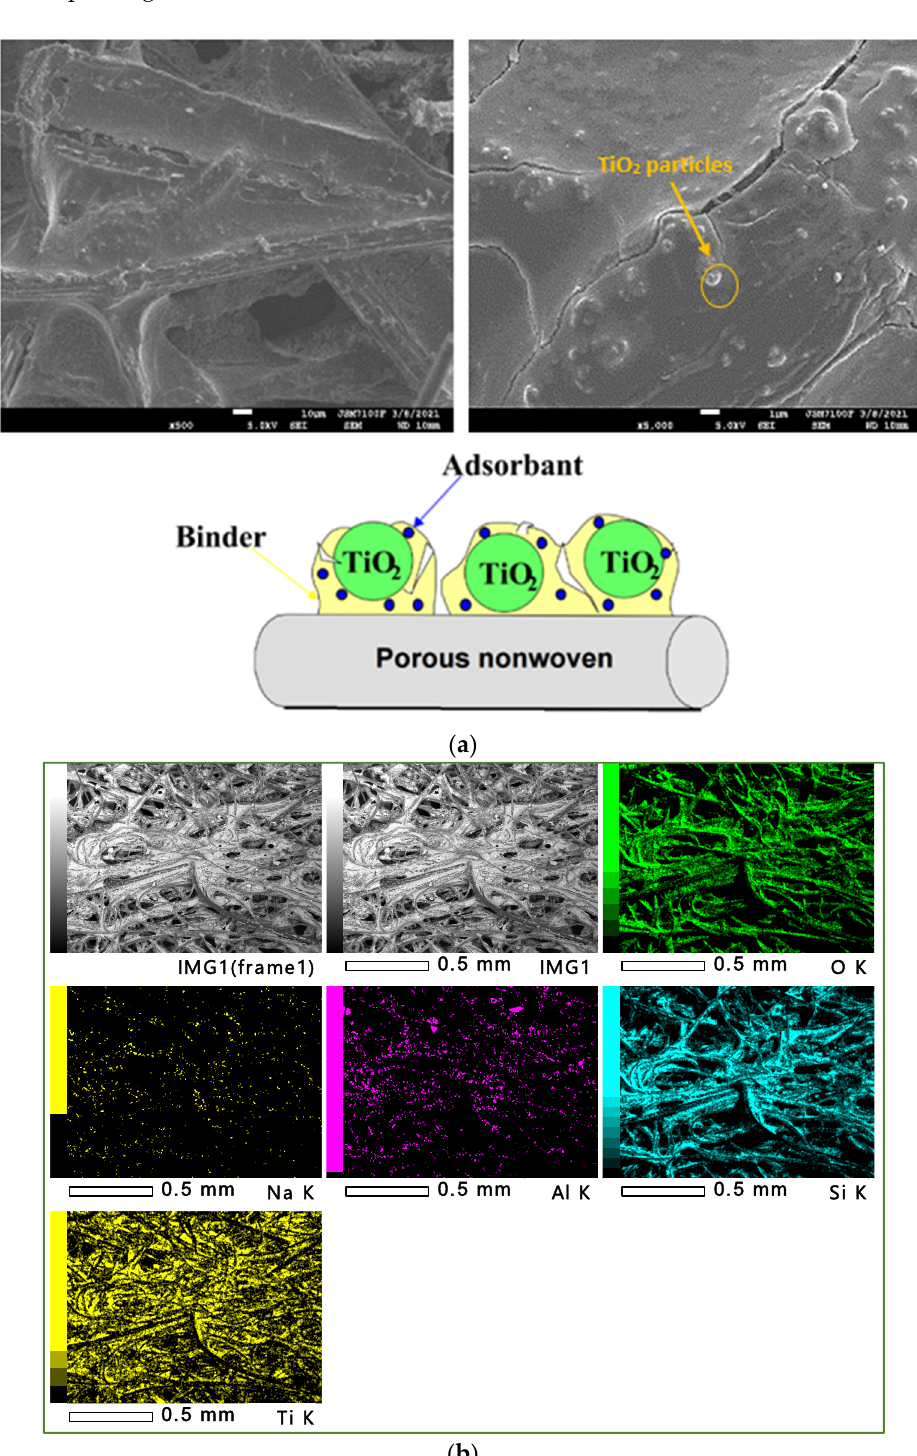
Figure 1. ( a ) Catalyst images under a scanning electron microscope, SEM (×500 and ×5000 as mag- nification ratios), with an illustrative presentation of the suspended TiO 2 nanoparticles. ( b ) Catalyst images, SEM/EDX, with an illustrative presentation of the suspended TiO 2 nanoparticles. The SEM/EDX analysis provided an enlarged view of the catalyst sample, showing the different elements of the TiO 2 deposited on the cellulosic paper, such as: titanium, sodium, oxygen, aluminum, and silicon corresponded to the silica deposit. Moreover, Fig- ure 1b shows a uniform Ti distribution in the cellulosic paper.